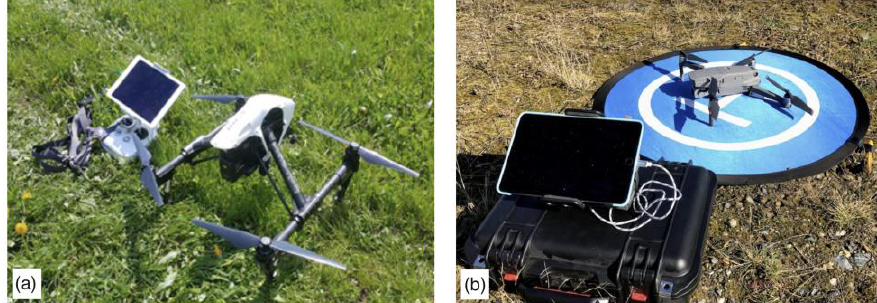
Figure 2. Imaging platforms used for monitoring. ( a ) DJI Inspire 1 Pro and ( b ) DJI Mavic 2 Pro.